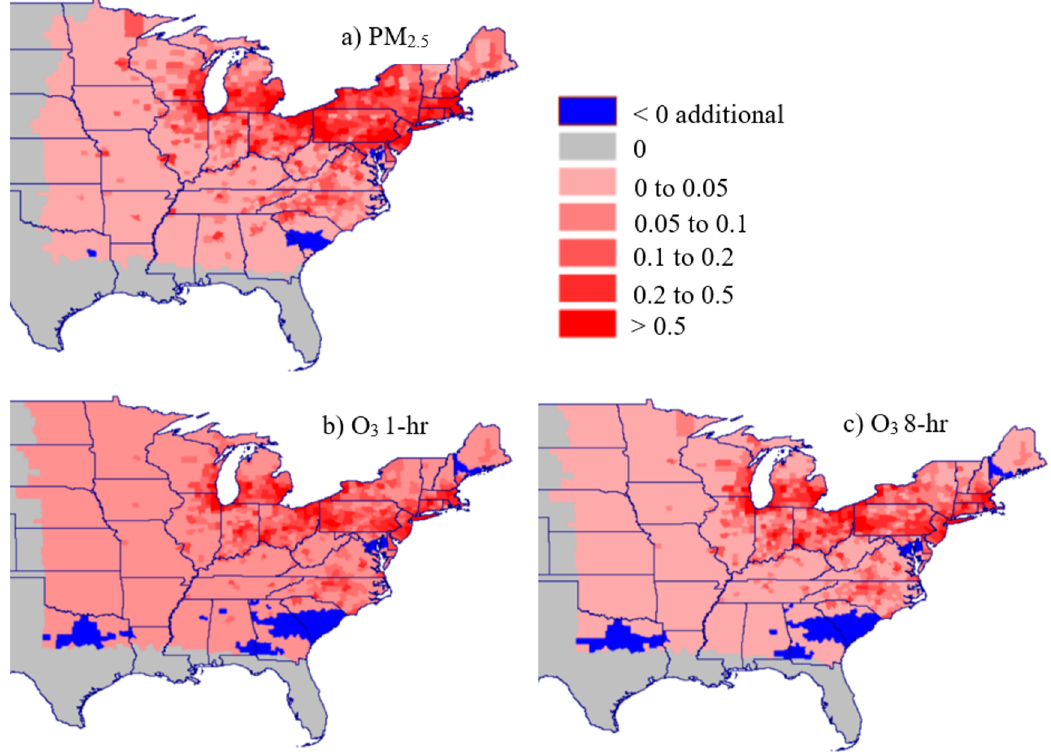
Fig 7. The mortality impacts of adaptation due to air pollution. Shown is the air-pollution-related mortality increase due to adaptation (the mid-century adaptation scenario minus the mid-century climate-only scenario) for (a) PM 2.5 as taken from the Expert F concentration–response function (the median function), (b) O 3 based on Levy et al. [97] using maximum daily 1-hour concentrations, and (c)